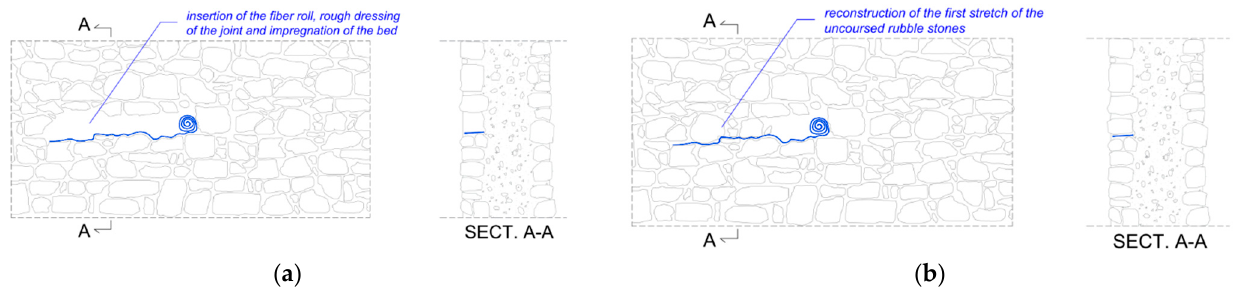
Figure 11. Relevant modifications of the proposed intervention for rubble uncoursed masonry: ( a ) unrolling and impregnation of the fiber roll and rough dressing of the bed; ( b ) reconstruction of the stretch of the ashlar course.